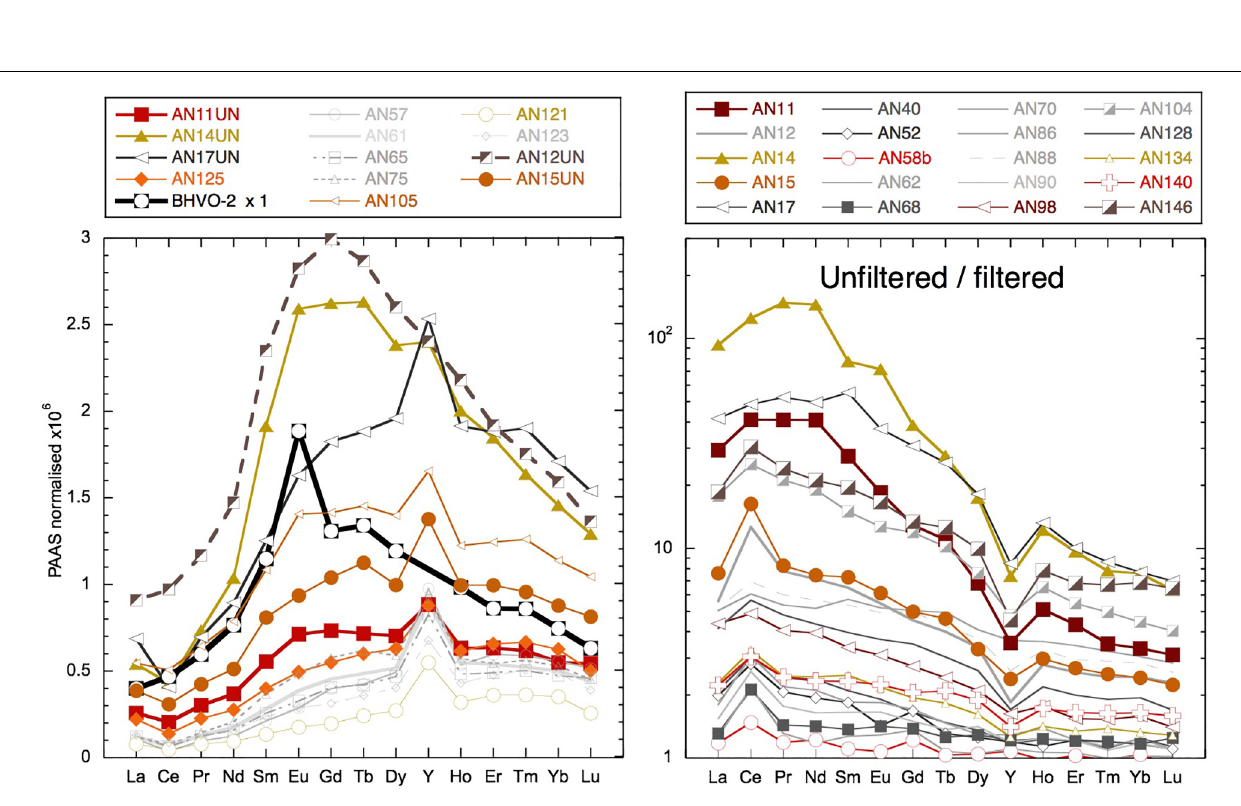
Frontiers in Marine Science |